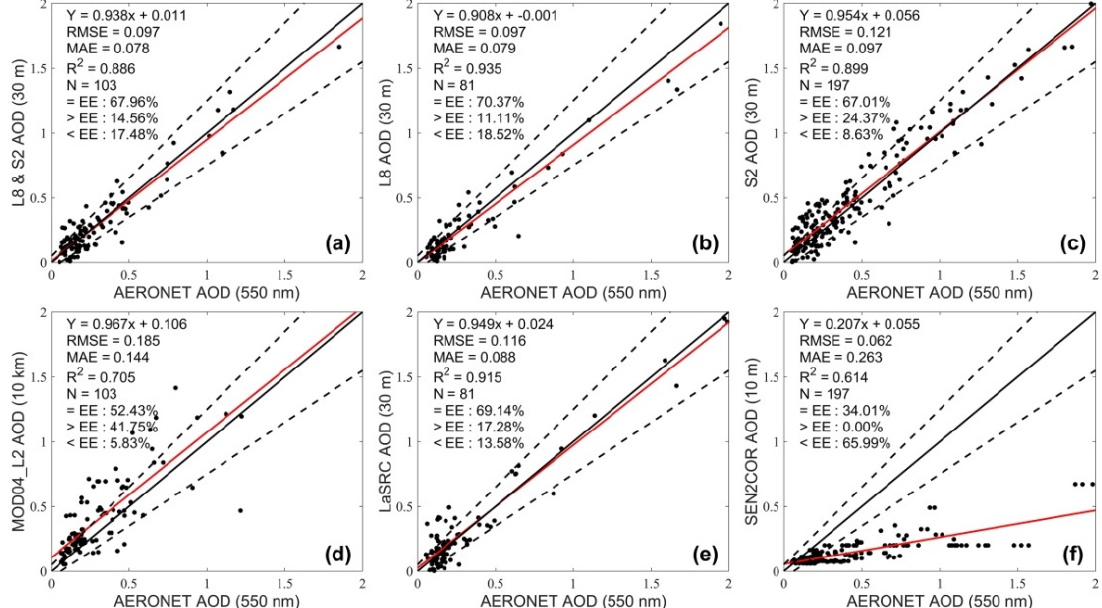
Figure 7. Comparison of the ( a – c ) retrieved AOD with ( d ) MOD04 DB&DT AOD, ( e ) LaSRC AOD and ( f ) SEN2COR AOD products.